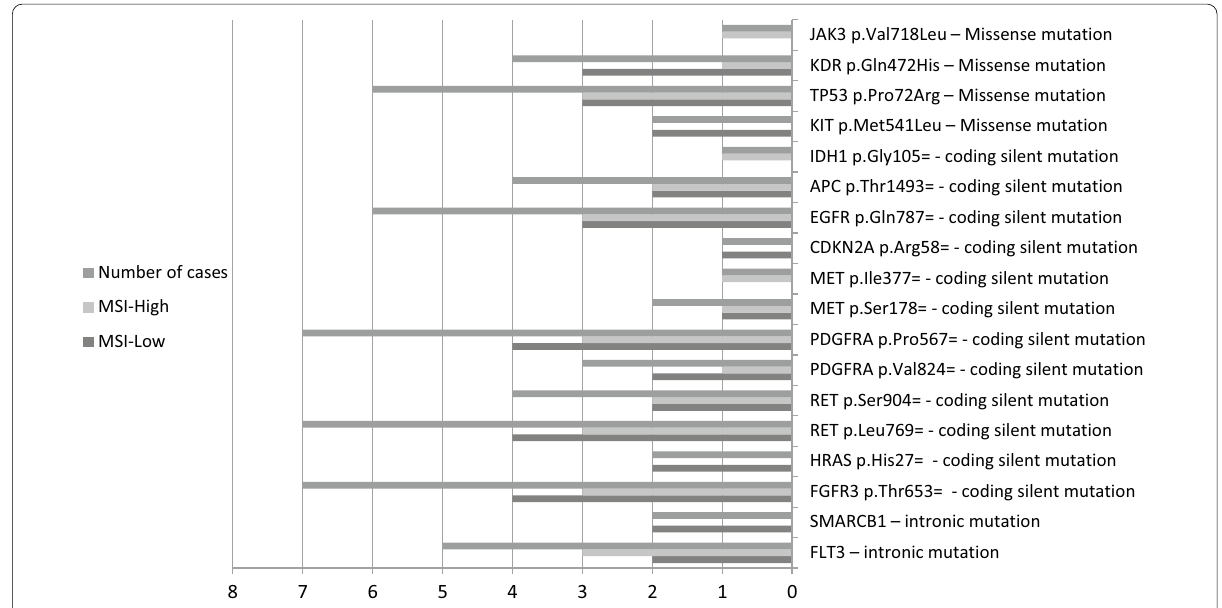
Fig. 1 Different studied activating mutations and MSI status in GBM